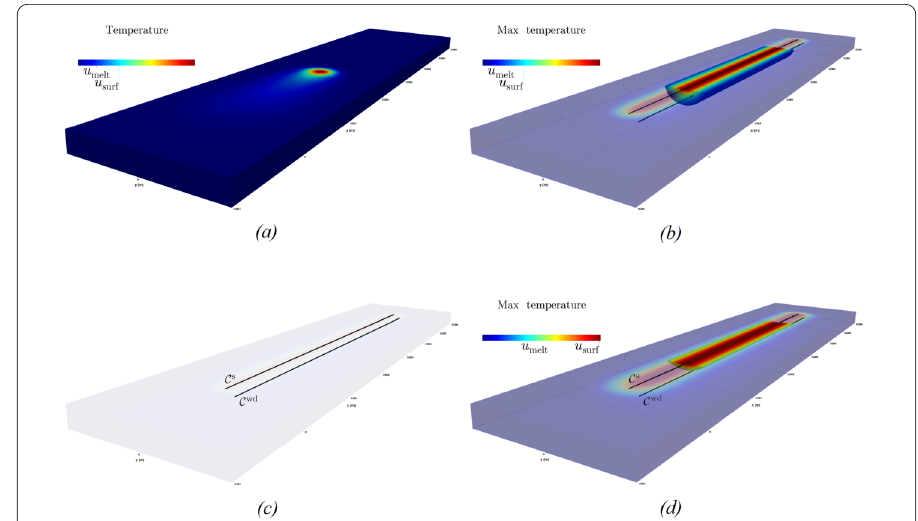
Figure 1 The desire to optimize the size and shape of the melt pool is reduced to a problem of tracking maximum temperatures on paths. (a) Temperature distribution due to a moving beam. (b) Maximum temperature obtained during melting, with the solidified volume highlighted. (c) Introduction of beam path C s and secondary path C wd . The secondary path is drawn along the desired liquid-solid interface. (d) Maximum temperature after optimization, with the solidified volume highlighted. The shape of this volume is optimized due to the tracking of reference temperatures u surf and u melt on C s and C wd ,